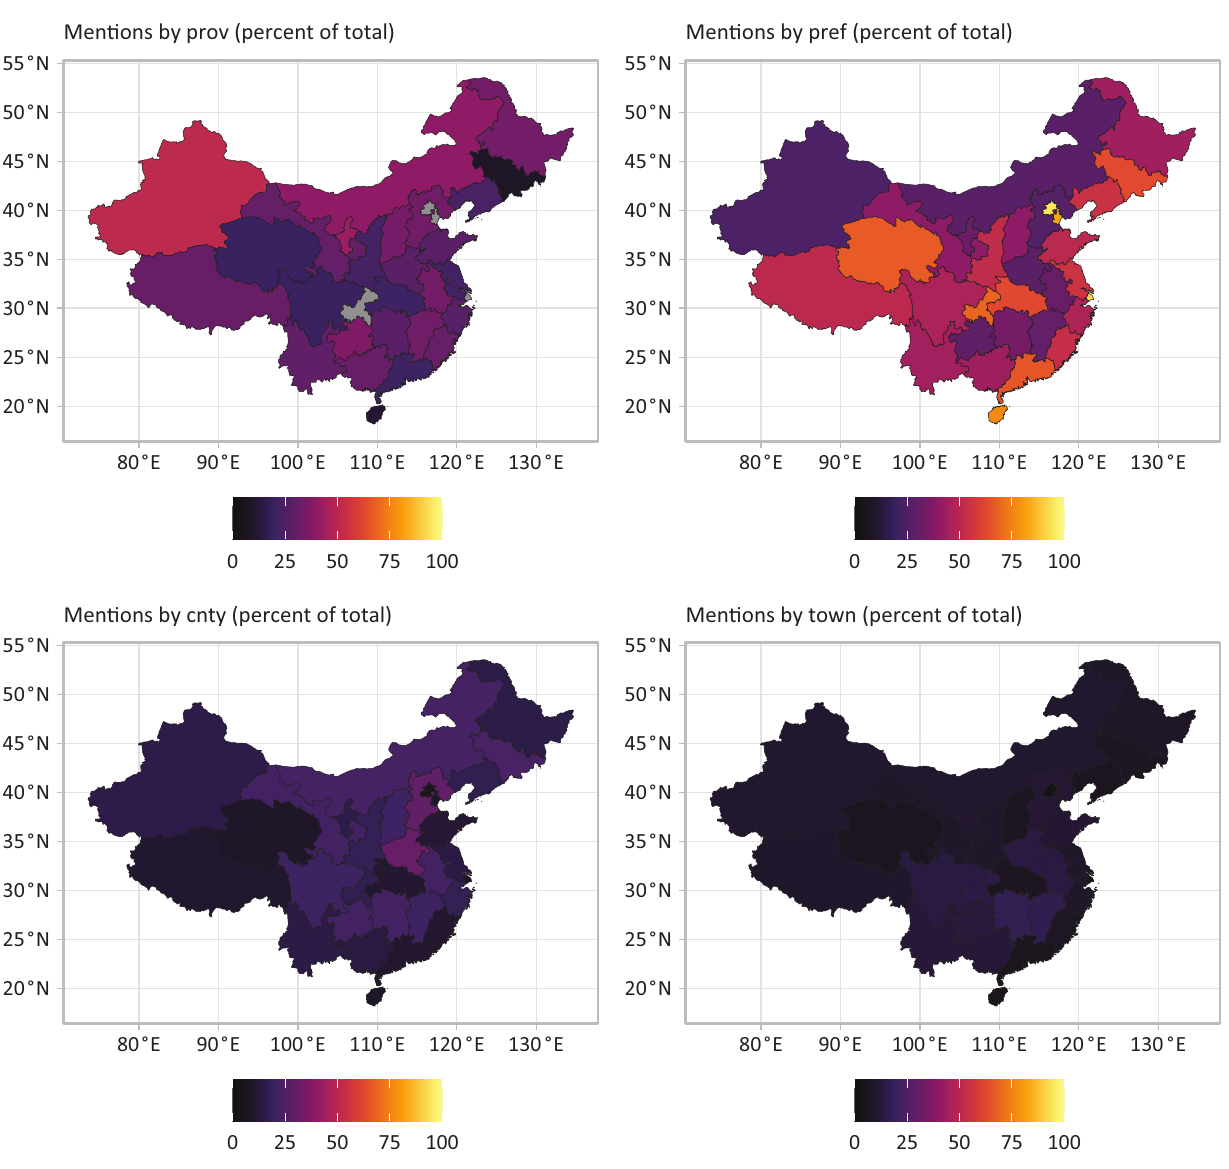
Figure 7. Place name mentions at different administrative levels, aggregated by province. Notes: Provinces are mentioned most often in the news media at different administrative levels. For example, the eastern coastal provinces are most often mentioned at the prefectural level, whereas the northwestern Xinjiang Uighur Autonomous Region is most often men‐ tioned by